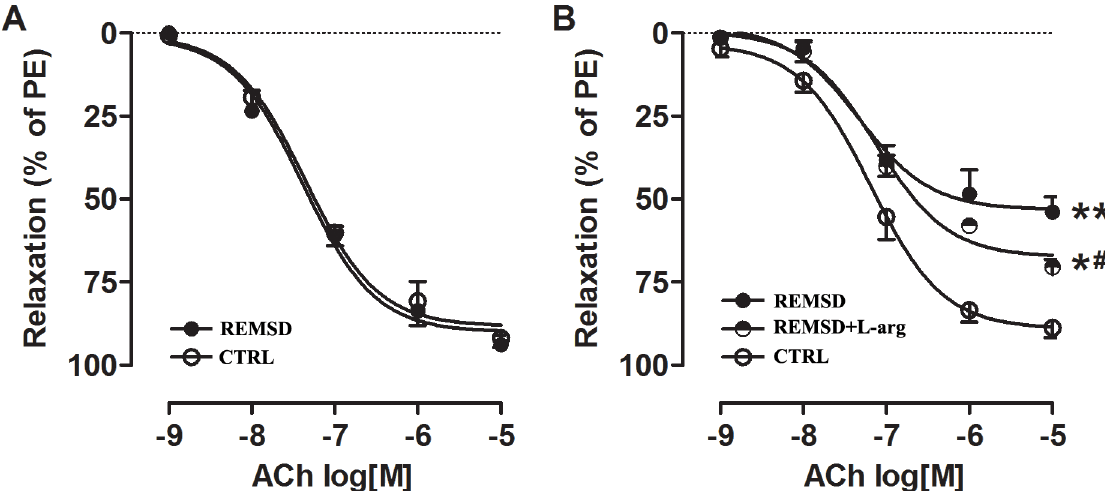
Fig 2. Acetylcholine (ACh)-induced vasorelaxation of the aortas of rats. (A)ACh-induced vasorelaxation of young-agedrats. (B)ACh-induced vasorelaxation of middle-aged.The dilationresponseto ACh is presentedas the percentageof the contractile responseinducedby phenylephrine (PE, 10 − 6 M). Each point represents a mean ± SEM;n = 6 rats per study group. * E max significantly different from that of CTRL ( * P < 0.05and ** P < 0.01). # E max significantly different from that of REMSD ( # P < 0.05). CTRL, control rats without REM sleep deprivation;REMSD,REM sleep deprivation; L-arg, L-arginine.